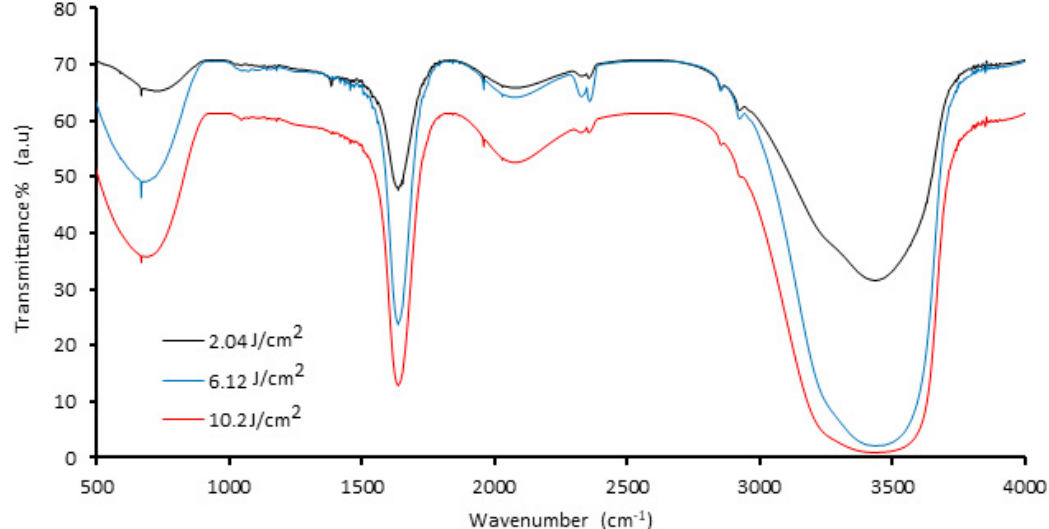
Figure 1. FTIR spectra of palladium nanoparticles (Pd NPs) synthesized via pulsed laser ablation of palladium target in distilled water with different laser fluences at 100 pulses.